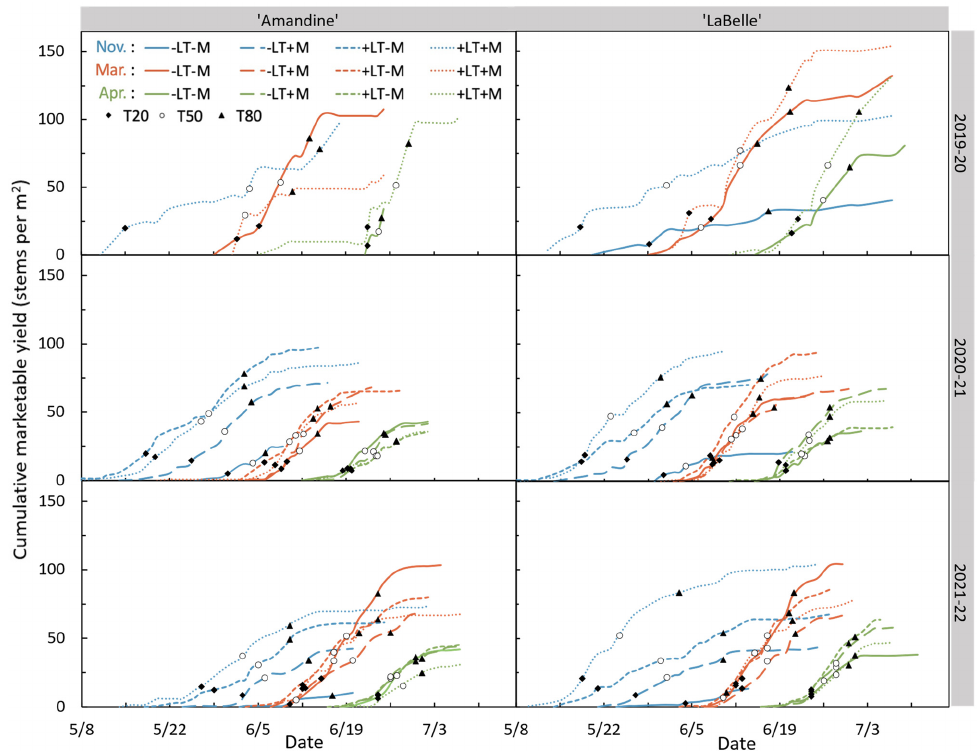
Figure 3. Cumulative marketable field yield of ‘Amandine’ ( left ) and ‘LaBelle’ ( right ) ranunculus in 2019–20 ( top ), 2020–21 ( middle ), and 2021–22 ( bottom ) in North Logan, UT by planting date (Nov.–blue; Mar.—red; Apr.—green) that were uncovered (-LT-M—solid) or insulated with mulch (-LT+M—long dashes), a low tunnel (+LT-M—short dashes), or mulch and a low tunnel (+LT+M— dots). T20 (diamonds), T50 (circles), and T80 (triangles) mark the completion of 20, 50, and 80% of marketable yield, respectively.